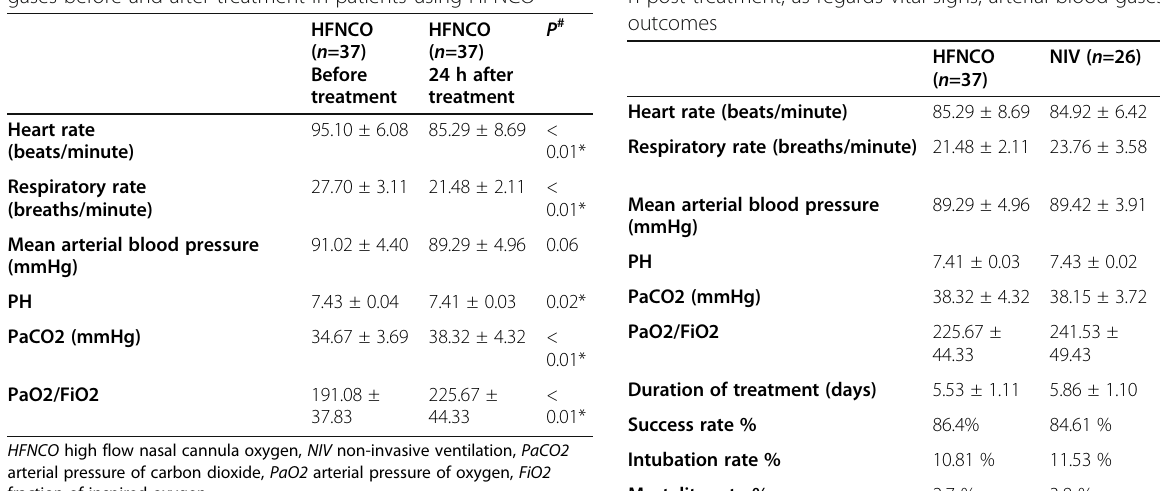
Table 6 Comparison between HFNCO group and NIV group 24 h post treatment, as regards vital signs, arterial blood gases,